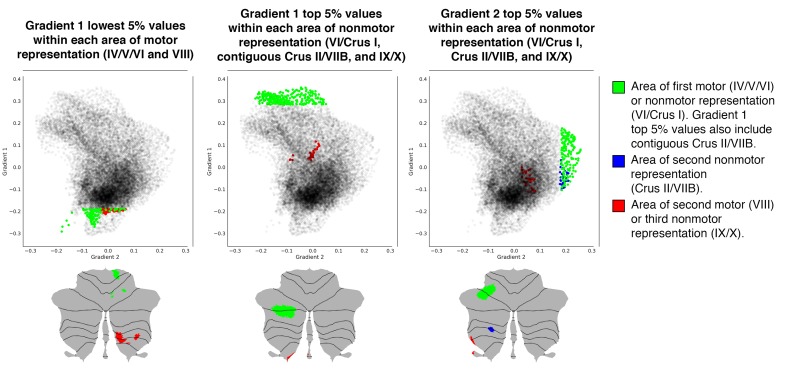
Investigation of individual areas of motor and nonmotor representation using data from one single subject (one resting-state run of 15 min).As in the group analysis, second motor and third nonmotor representations (shown in red) were consistently located at less extreme positions along Gradient 1 and/or 2. Given the asymmetries between left and right hemisphere in the analysis of a single subject (see Figure 1—figure supplement 3), maps in these figures include only the right hemisphere for Gradient 1 lowest 5% values and only the left hemisphere for Gradient 1 and 2 highest 5% values. Opacity of black dots in these plots was decreased to improve the visibility of green, blue and red dots. Gradients were smoothed with sigma = 4.